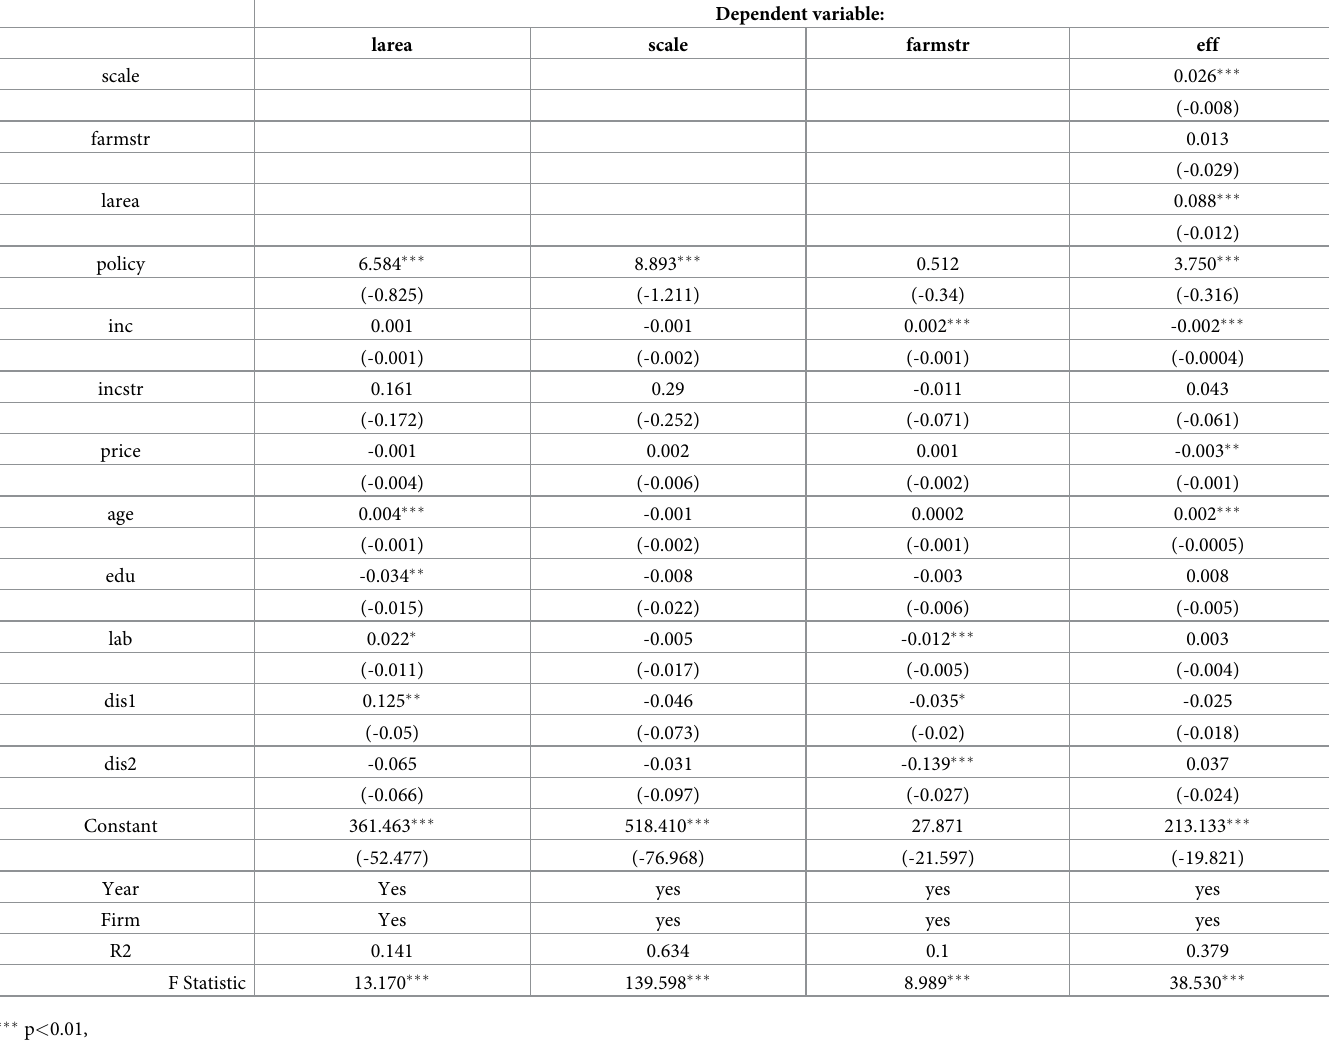
Table 5. Estimation results of parallel mediating effects model of the effect of GECP on the efficiency of breeding